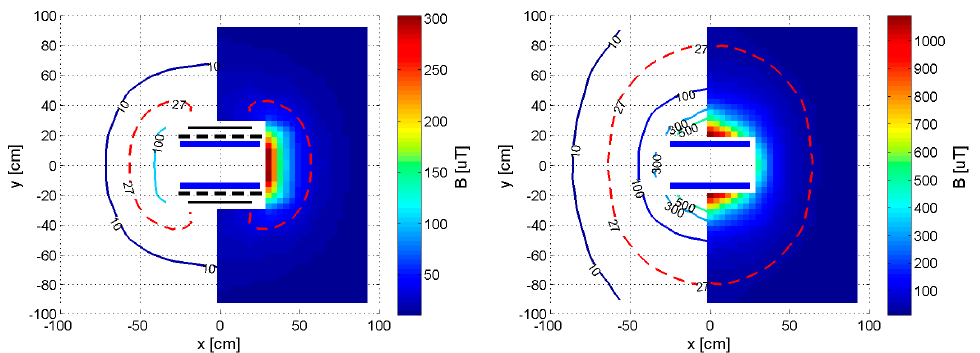
Figure 8. Measured flux density (RMS values) around the coupling coils—left shielded. right unshielded.